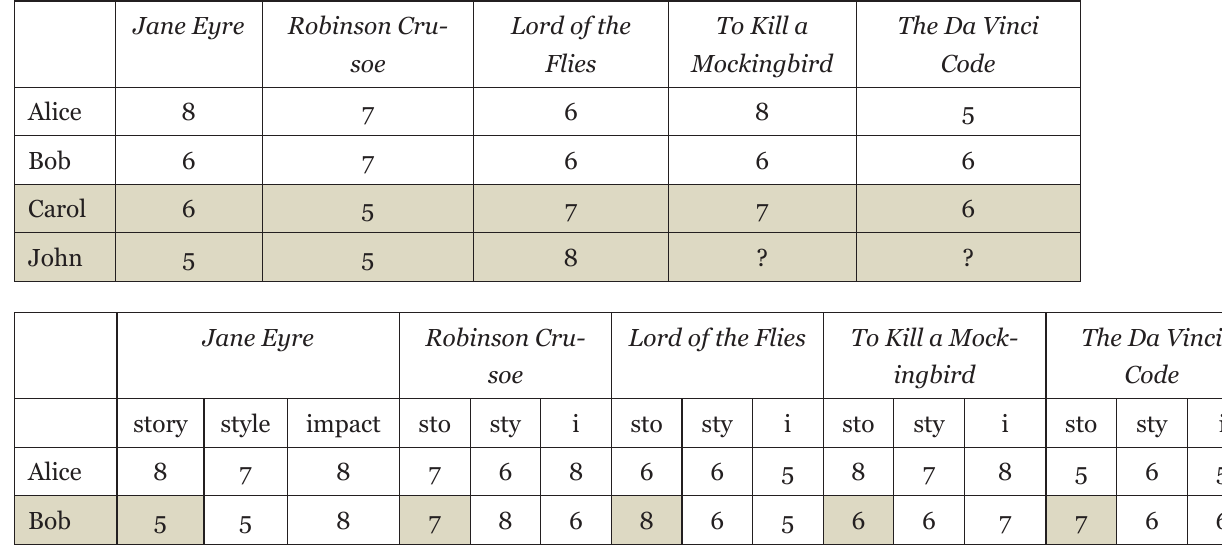
An Example of a Single-dimensional (Top) and Multidimensional (Bottom) Book